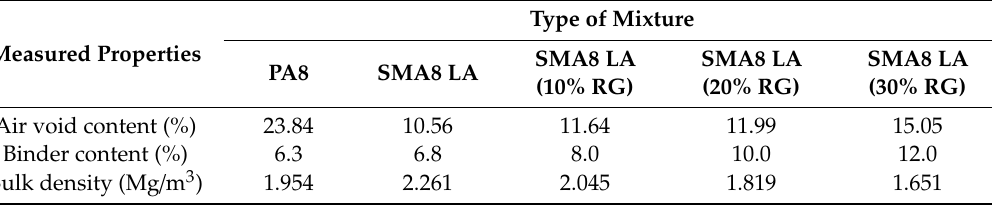
Table 3. The characteristics of tested